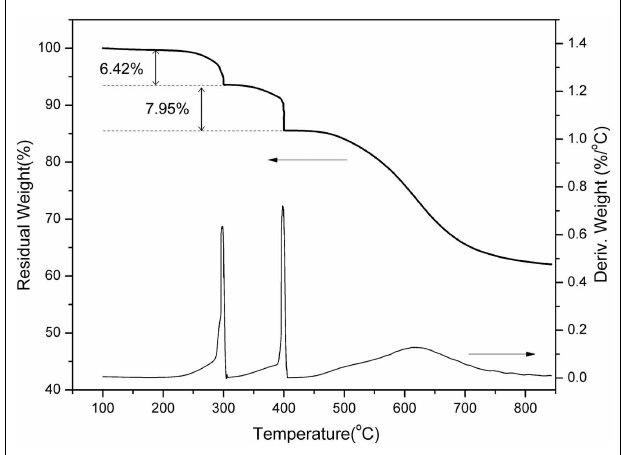
FIGURE 8 |Thermogravimetric analysis of poly( o AI-a) . At 300 and 400°C, isothermal heating was applied for 1h